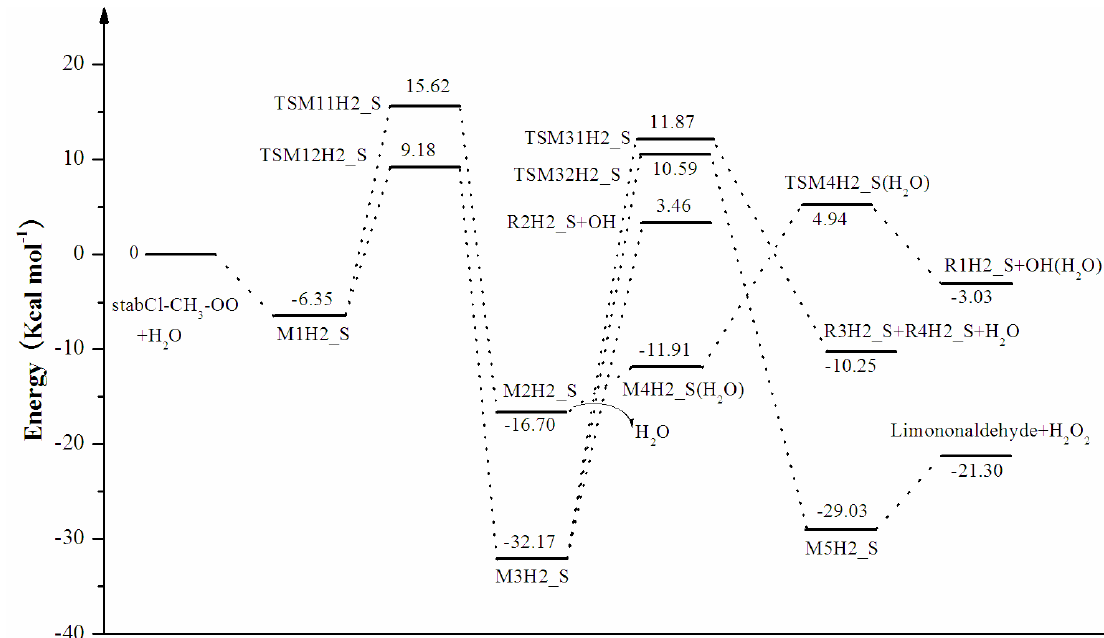
Figure 5. StabCI-CH -OO + H O reaction coordinates: relative energies of the stationary 3 2 -OO and H O ground-state potential energy points located on the separate stabCI-CH 3 2 surface. The energy values are given in kcal mol − 1 and were calculated using CCSD(T)/6-